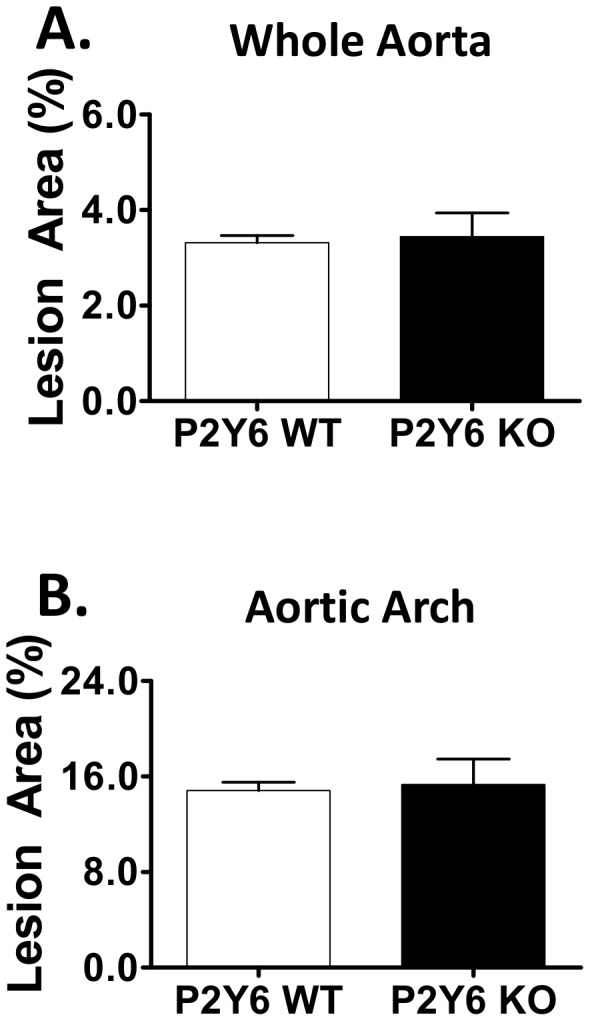
Atherosclerosis development with Western Diet Feeding.En face plaque quantification of excised mouse aortas using oil red O. A) Lesion area measured in the whole aorta from the ascending aorta to the iliac bifurcation. B) Regional atherosclerosis in the aortic arch. The percentage of positive stained area with respect to total analyzed aortic area. Group sizes: n = 12 P2Y6 WT mice; n = 13 P2Y6 KO mice.